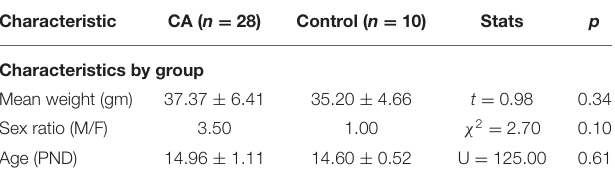
TABLE 2 | ADC values at day 1 and days 7–10 after experimental procedure. Structure (Day post-procedure)